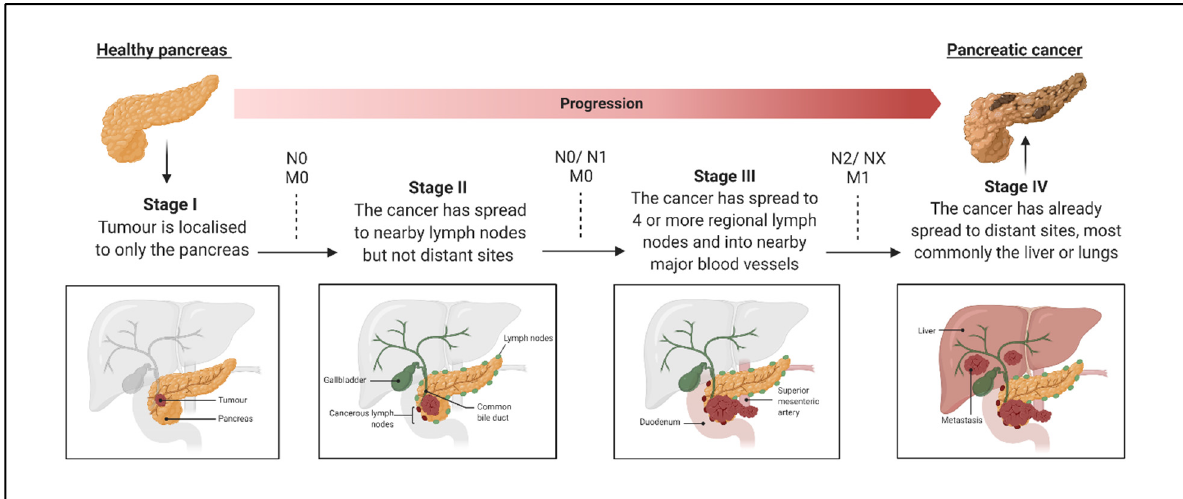
Figure 1. Schematic of Pancreatic Ductal Adenocarcinoma (PDAC) Progression from Early Stages I–II to Advanced Stages III and IV, Including Classification of Regional Lymph Node Spread (N) and Metastasis (M) [11]. N0—the cancer has not spread to nearby lymph nodes; N1—the cancer has spread to <3 regional lymph nodes; N2—the cancer has spread to ≥ 4 regional lymph nodes; NX—regional lymph nodes cannot be assessed; M0—no metastasis to distant organs or lymph nodes; M1—metastasis to distant organs or distant lymph nodes. Adapted from “Pancreatic Cancer Staging”, by BioRender.com. Retrieved from https://app.biorender.com/biorender-templates (accessed on 13 November 2021).